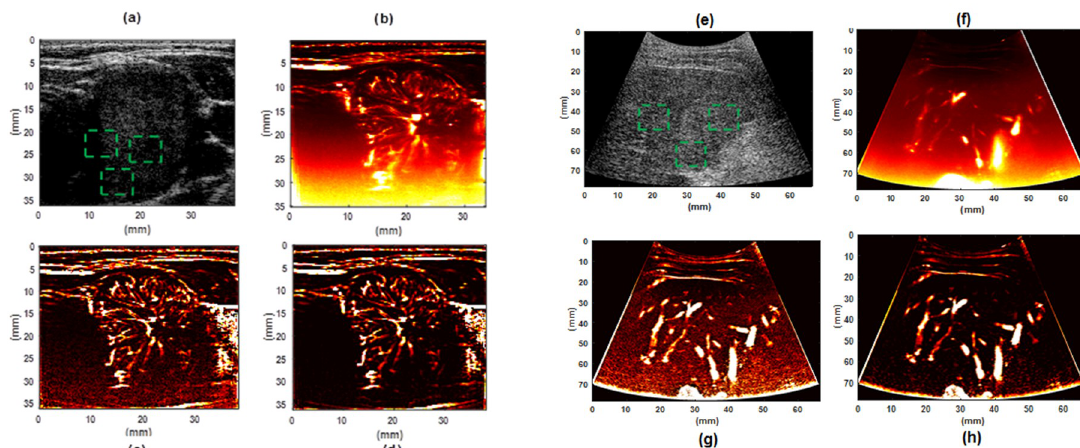
Figure 9. B-mode images of a ( a ) malignant thyroid nodule and ( e ) a pathological liver; ( b , f ) are their gross vasculature SVD images; ( c , g ) are their vasculature images after SVD+TH, respectively; and ( d , h ) are the final images of vasculature after applying the proposed denoising method (NLM+TH).